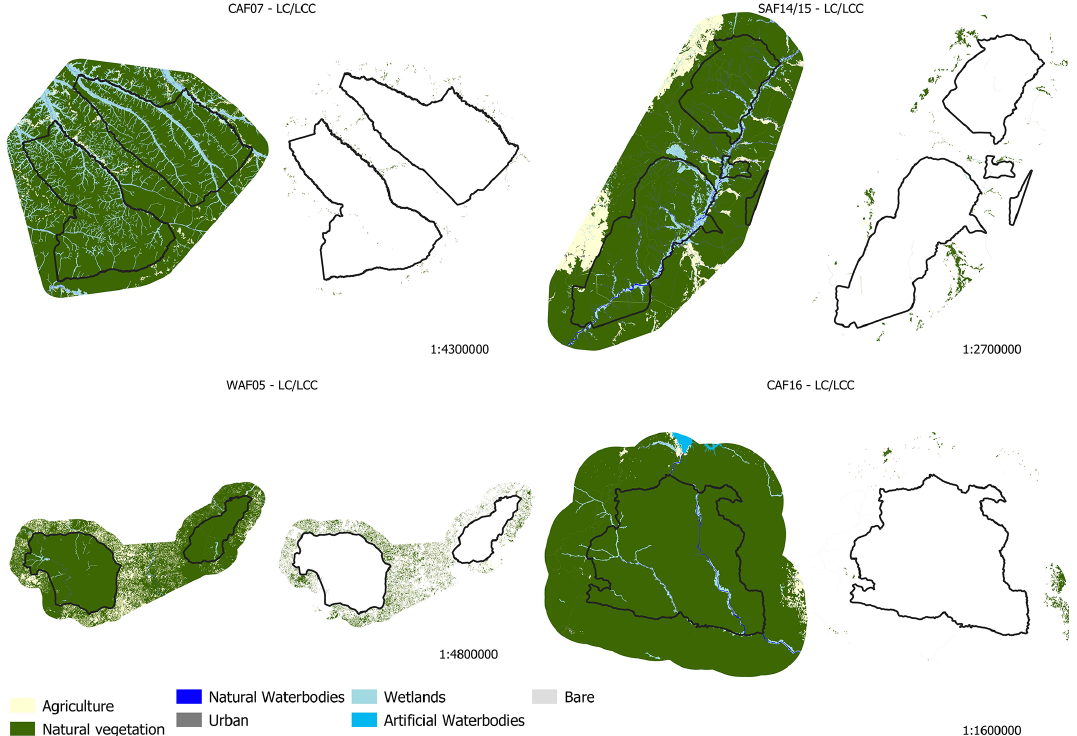
Figure 4. Key landscapes for conservation – Dichotomous classification level. The boundaries (black polygons) represent protected areas (IUCN categories I–IV) within the KLCs. Both land cover and land cover change are presented for each